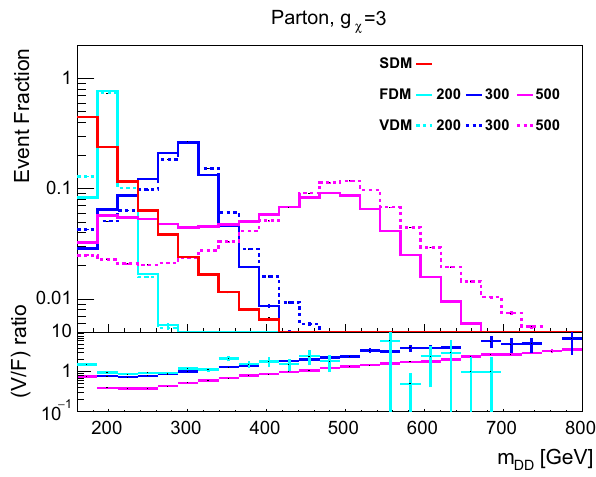
Fig. 2 Distributions of DM pair invariant mass in the t ¯ t +DM asso- ciated production channel at 100 TeV pp collider for 80 GeV DM at LO (left) and NLO (right). The lower plots show the ratios between the event fractions of FDM and VDM. The dashed lines correspond to the